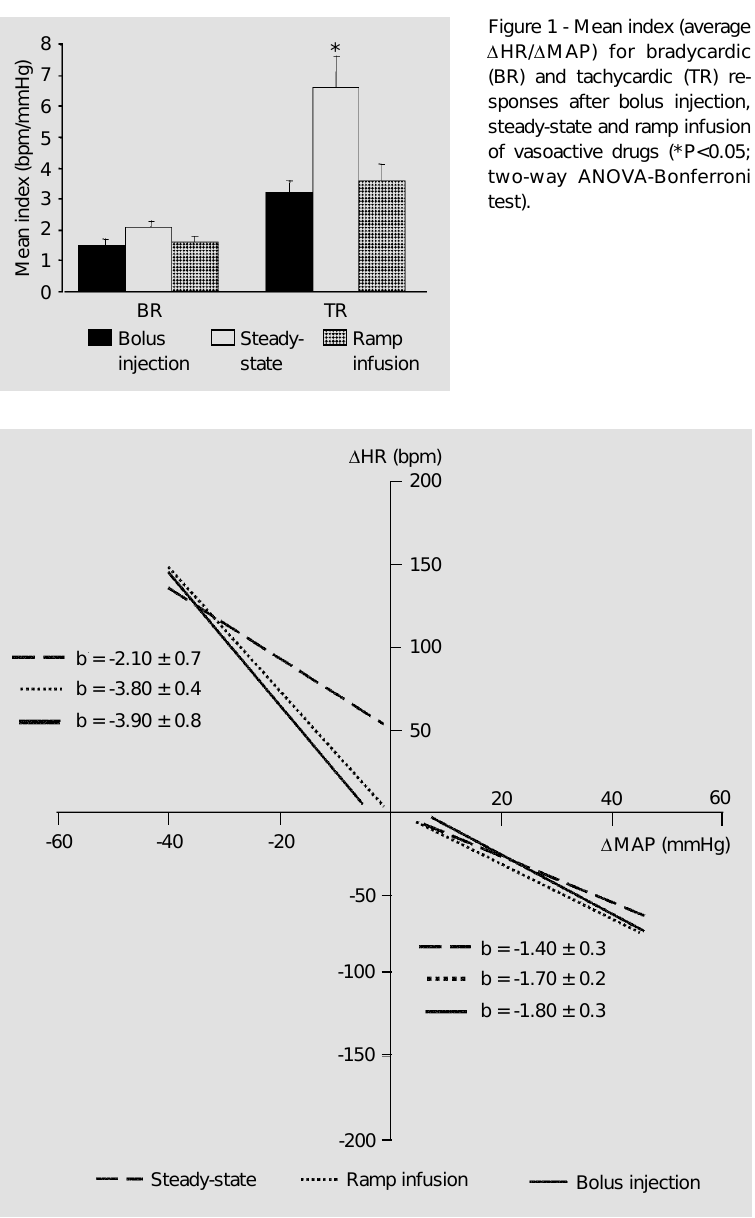
Figure 2 - Baroreflex sensitivity determined by linear regression (b) for bradycardic and tachycardic responses after bolus injection, steady-state and ramp infusion of vasoactive